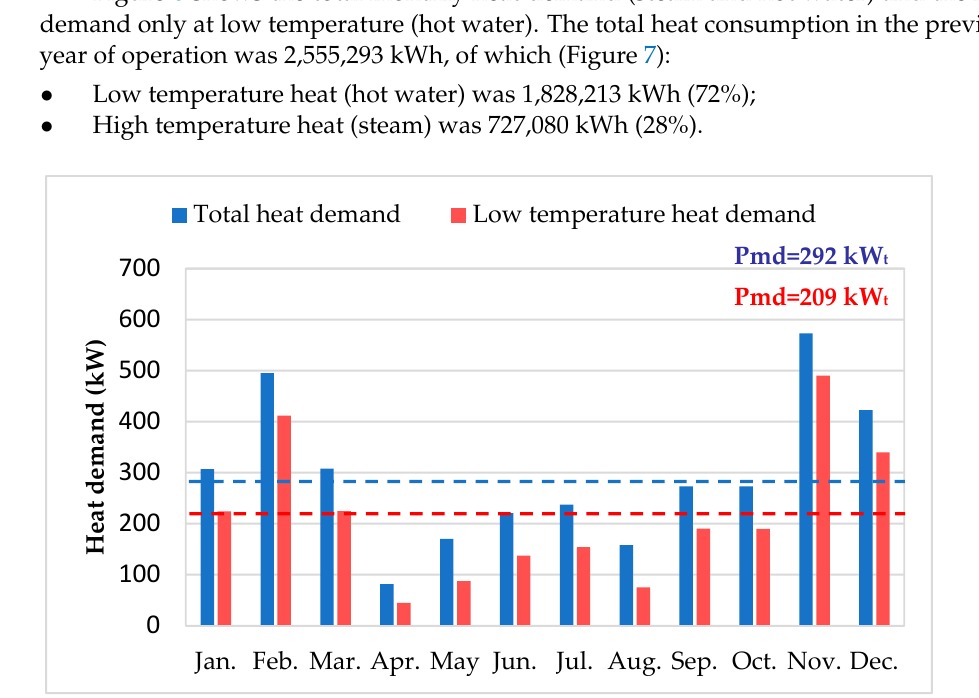
Figure 6. Average monthly heat demand.